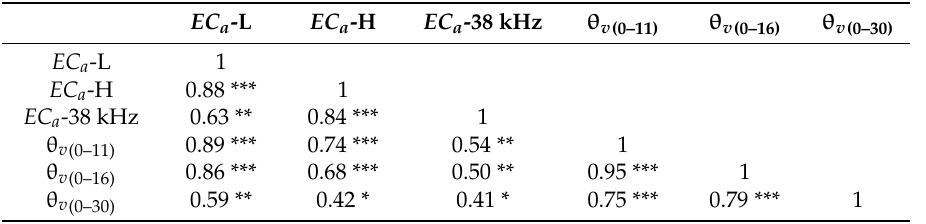
Table 3. Pearson’s correlation coefficients of the EC a measurements of CMD-MINIEXPLORER and GEM-2 and TDR measured SMC at the study site ( n = 20). Significance is reported at the 0.1 (*), 0.05 (**), and 0.001 (***) p -values.